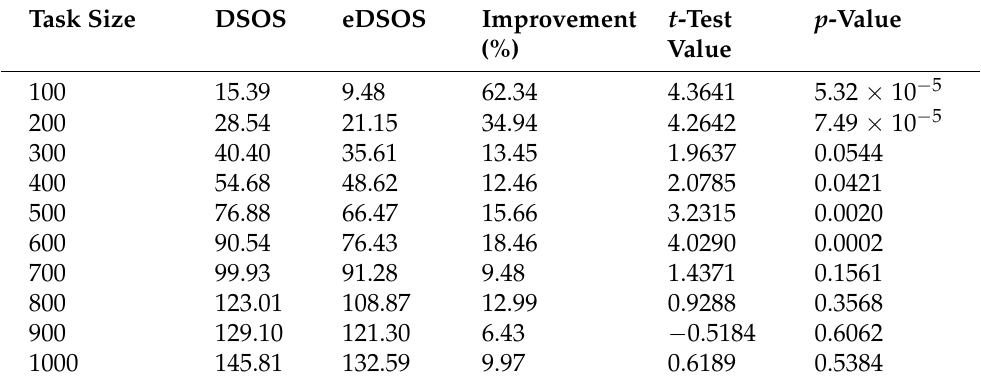
Table 10. Comparison of the response times of DSOS and eDSOS for the dataset with the left-half distribution.